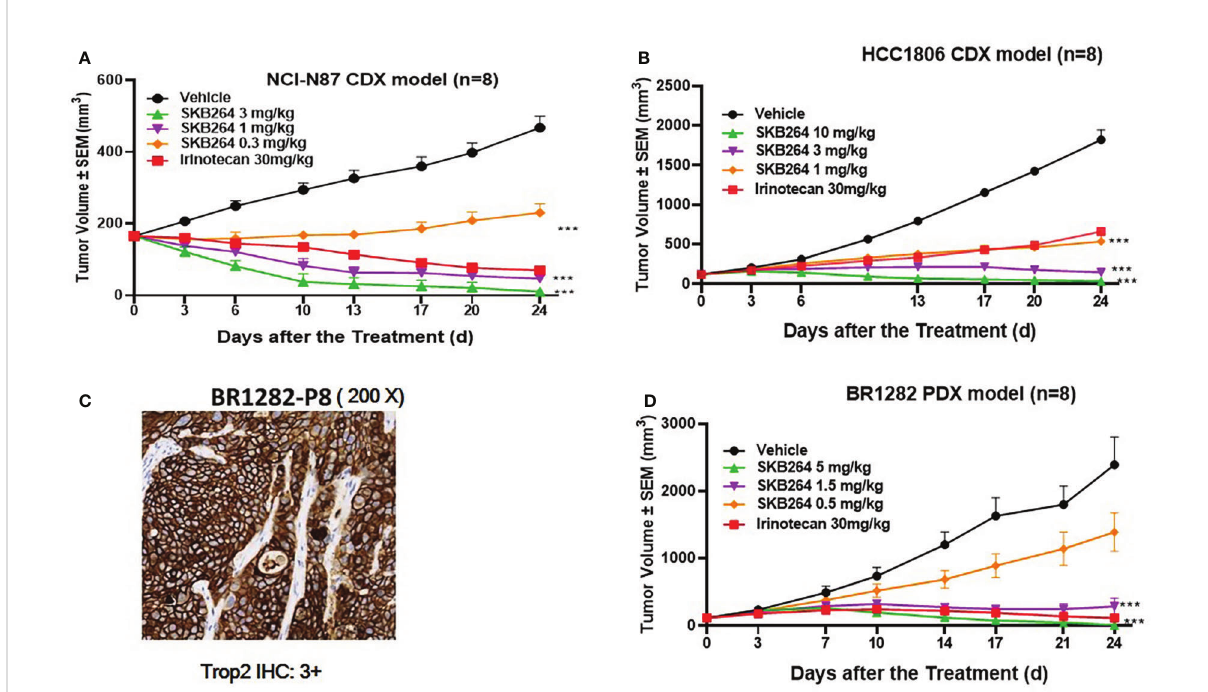
FIGURE 4 In vivo ef fi cacy of the SKB264 treatment. Two-tailed paired t -test, *** p < 0.001 ( vs . vehicle). (A) Antitumor ef fi cacy of SKB264 in the HCC1806 xenograft model. The tumor-bearing mice were intravenously administered with SKB264 (3, 1, and 0.3 mg/kg, respectively), irinotecan, and vehicle control, n = 8. (B) Antitumor ef fi cacy of SKB264 in the HCC1806 xenograft model. The tumor-bearing mice were intravenously administered with SKB264 (10, 3, and 1 mg/kg) and vehicle control, n = 8. (C) IHC analysis of TROP2 expression in the BR1282 xenografted tumor. IHC staining intensity: 3+ (high expression): >10% of tumor cells showed strong cell membrane staining. (D) In vivo antitumor ef fi cacy of SKB264 in BR1282 xenograft model ( n =